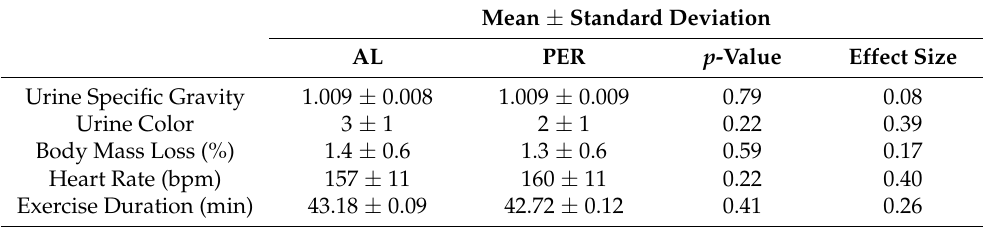
Table 1. Hydration and 10 k